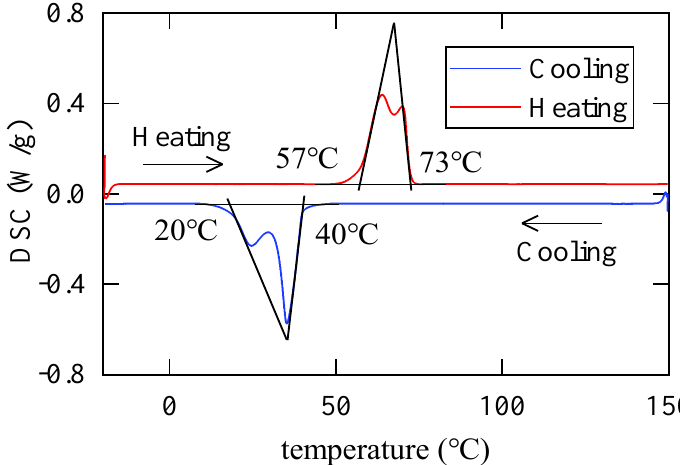
Figure 1. DSC results of SMA